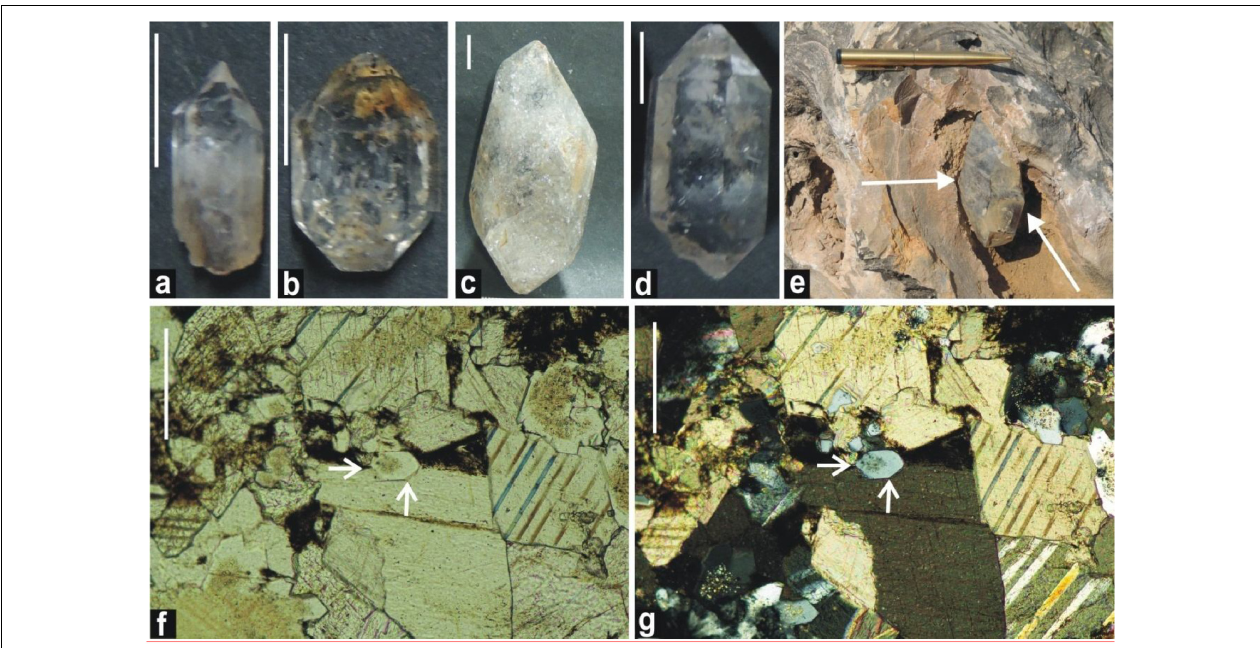
FIGURE 8 | Variety of doubly-terminated quartz crystals from the Salkhan Limestone recorded at Newari locality. Hand specimens of colorless, prismatic, white, and smoky quartz crystals are shown (a–d) and scale bars for the same are 1 cm. Field photograph shows the relationship of quartz crystal with associated stromatolite, length of pen is 13.2 cm (e) . Doubly-terminated quartz crystal in petrographic thin sections under the plane and cross polarized light indicated by white arrow (f,g)